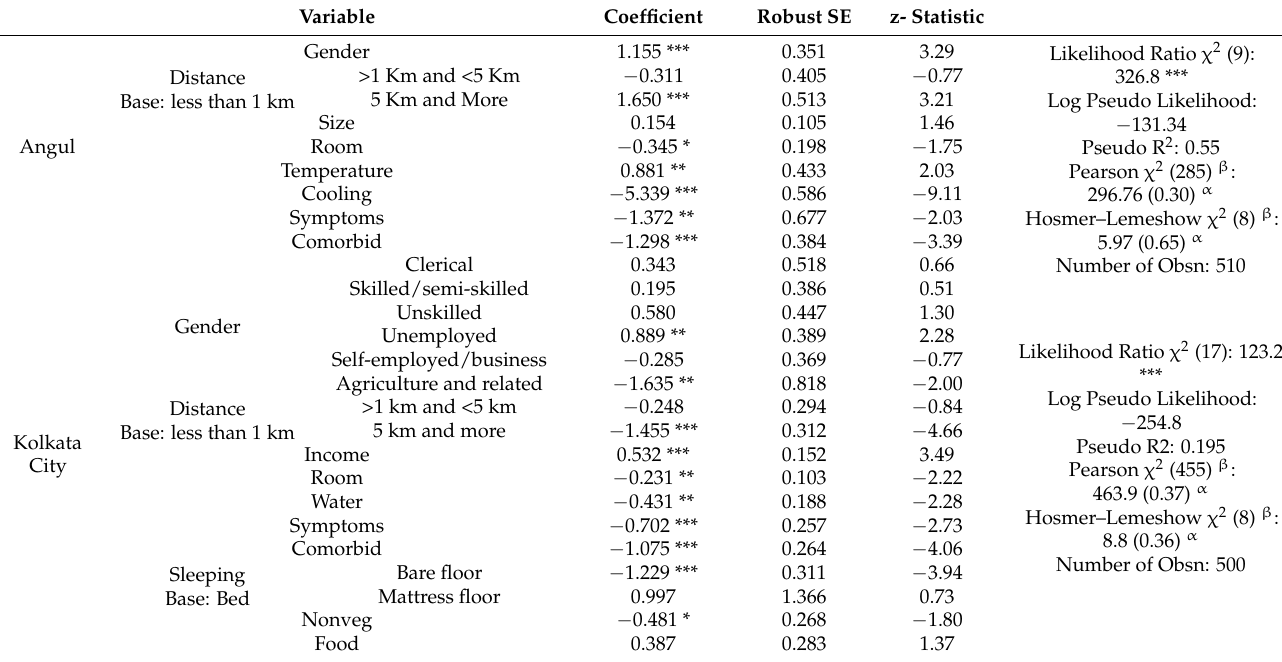
Table 3. Logistic regression on characteristics of household Vulnerability to extreme HEAT (Angul and